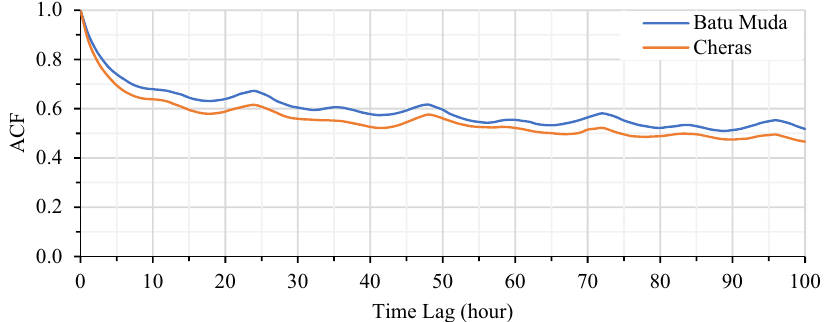
Figure 4. Autocorrelation coefficient of PM2.5 concentration.